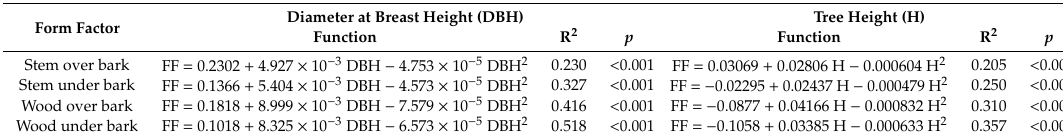
Table 4. Functions for estimating form factors using diameter and height.